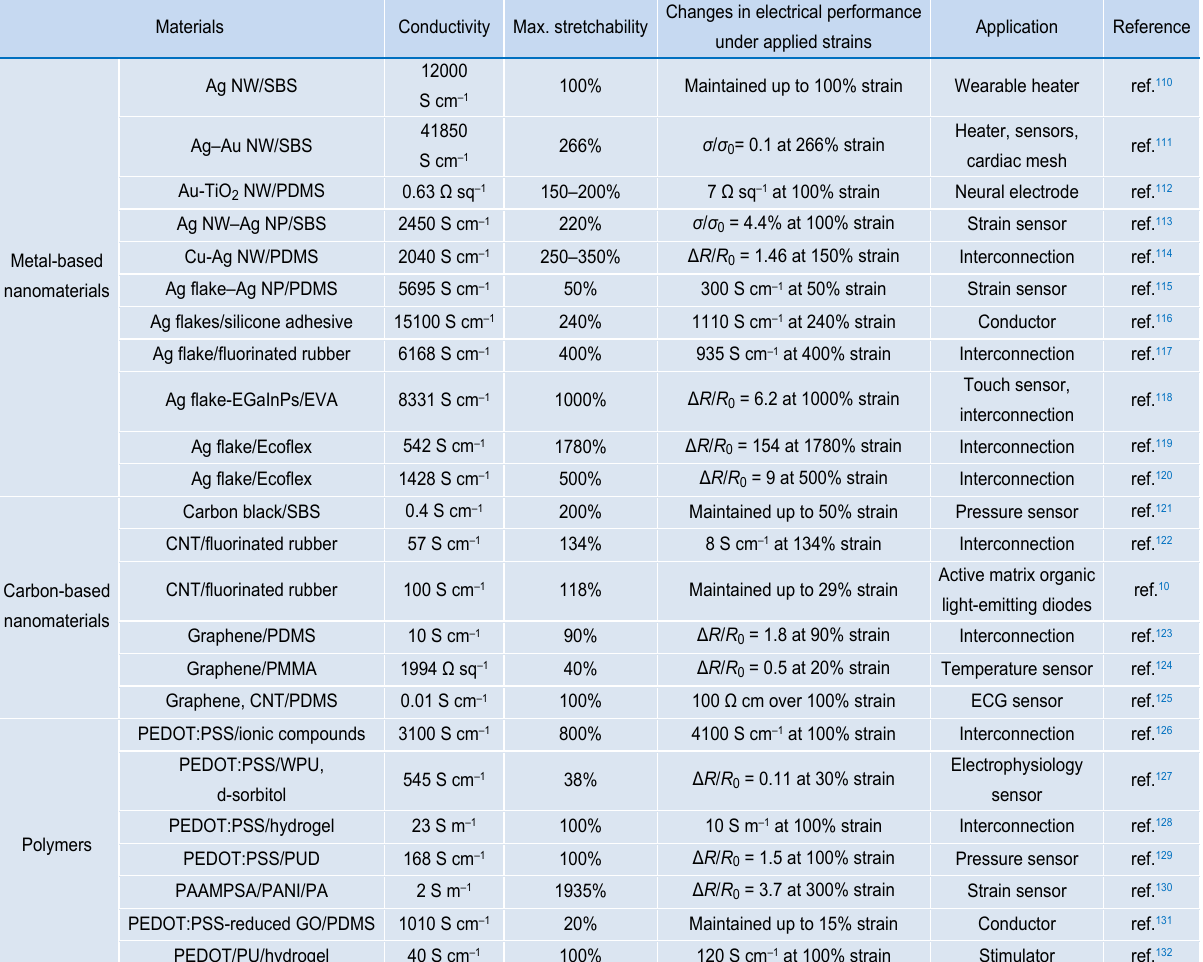
Table 1 | Electrical/mechanical performances of intrinsically stretchable conducting materials.